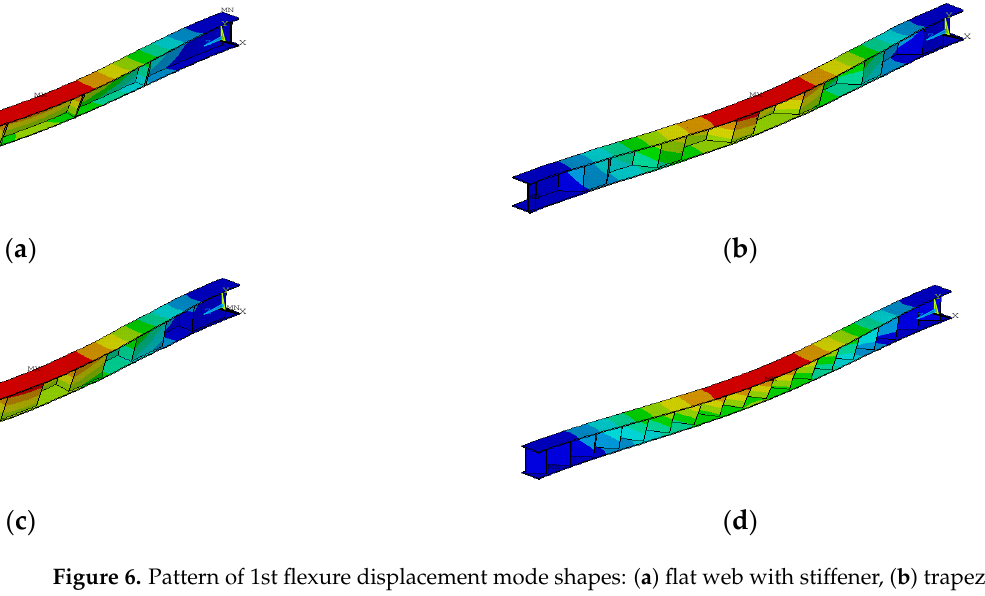
Figure 6. Pattern of 1st flexure displacement mode shapes: ( a ) flat web with stiffener, ( b ) trapezoidal web, ( c ) rectangular web, and ( d ) triangular web.